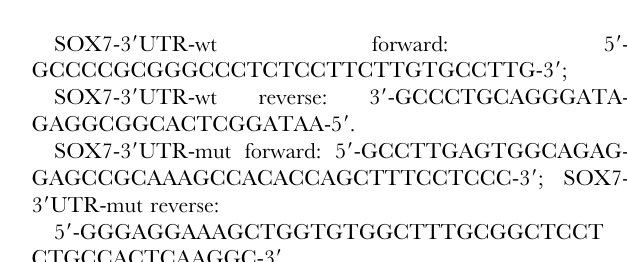
Figure 3. Inhibition of miR-184 reduces the proliferation of HCC cells. A . Real-time PCR analysis of miR-184 expression in Hep3B and Huh7 cells transfected with miR-184 inhibitor. B . The proliferation ability of HCC cells transfected with an miR-184 inhibitor or negative control (NC), analyzed by the MTT assay. C . Representative micrographs (left) and quantifications (right) of crystal violet stained cell colonies formed by indicated HCC cell lines, 10 days after inoculation. D . The tumorigenicity of HCC cells transfected with miR-184 inhibitor or NC, as determined by an anchorage- independent growth ability assay. Colonies larger than 0.1 mm were scored. E . Flow cytometry analysis of indicated HCC cells transfected with miR- 184-inhibitor or NC. Each bar represents the mean 6 SD of three independent experiments. * P , 0.05.